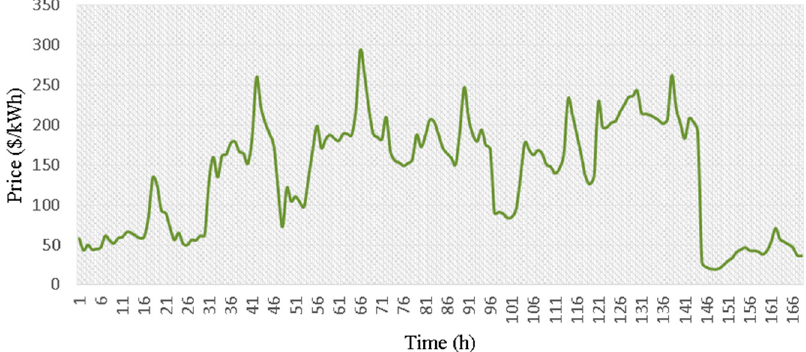
Figure 2. Average spot market prices during the scheduling period.